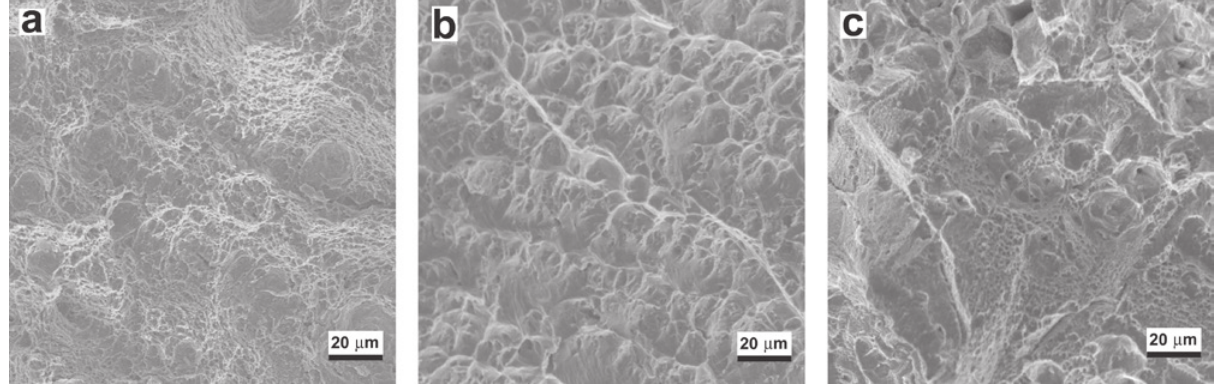
Fig. 7: SEM-fractographs of different regions of the T91/TP316H weldment in thermally exposed state at 600 °C/1000 h after room- temperature tensile testing without hydrogen charging: T91 steel HAZ (a), Ni WM Thermanit Nicro 82 (b), TP316H steel HAZ (c).